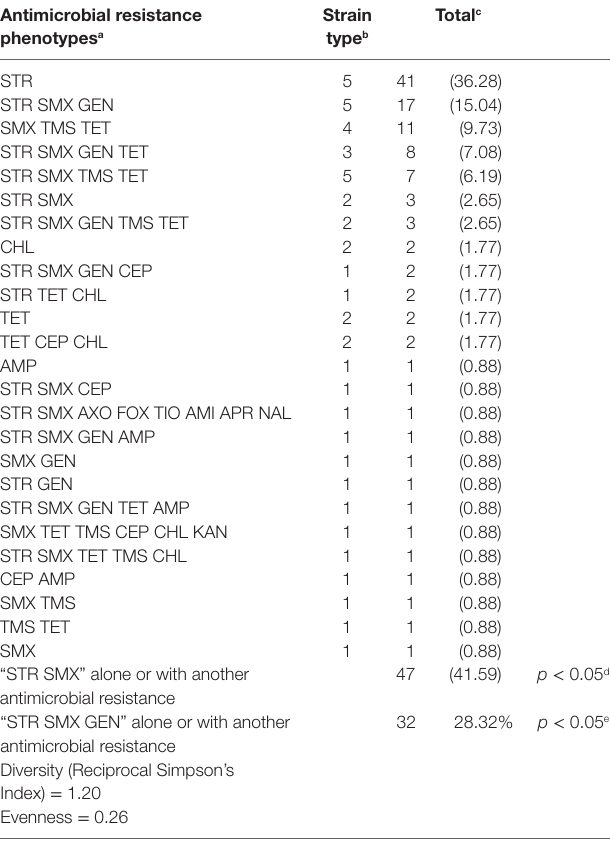
TaBle 2 | Diversity of antimicrobial resistance phenotypes in Salmonella isolated from two commercial poultry farms. antimicrobial resistance phenotypes a